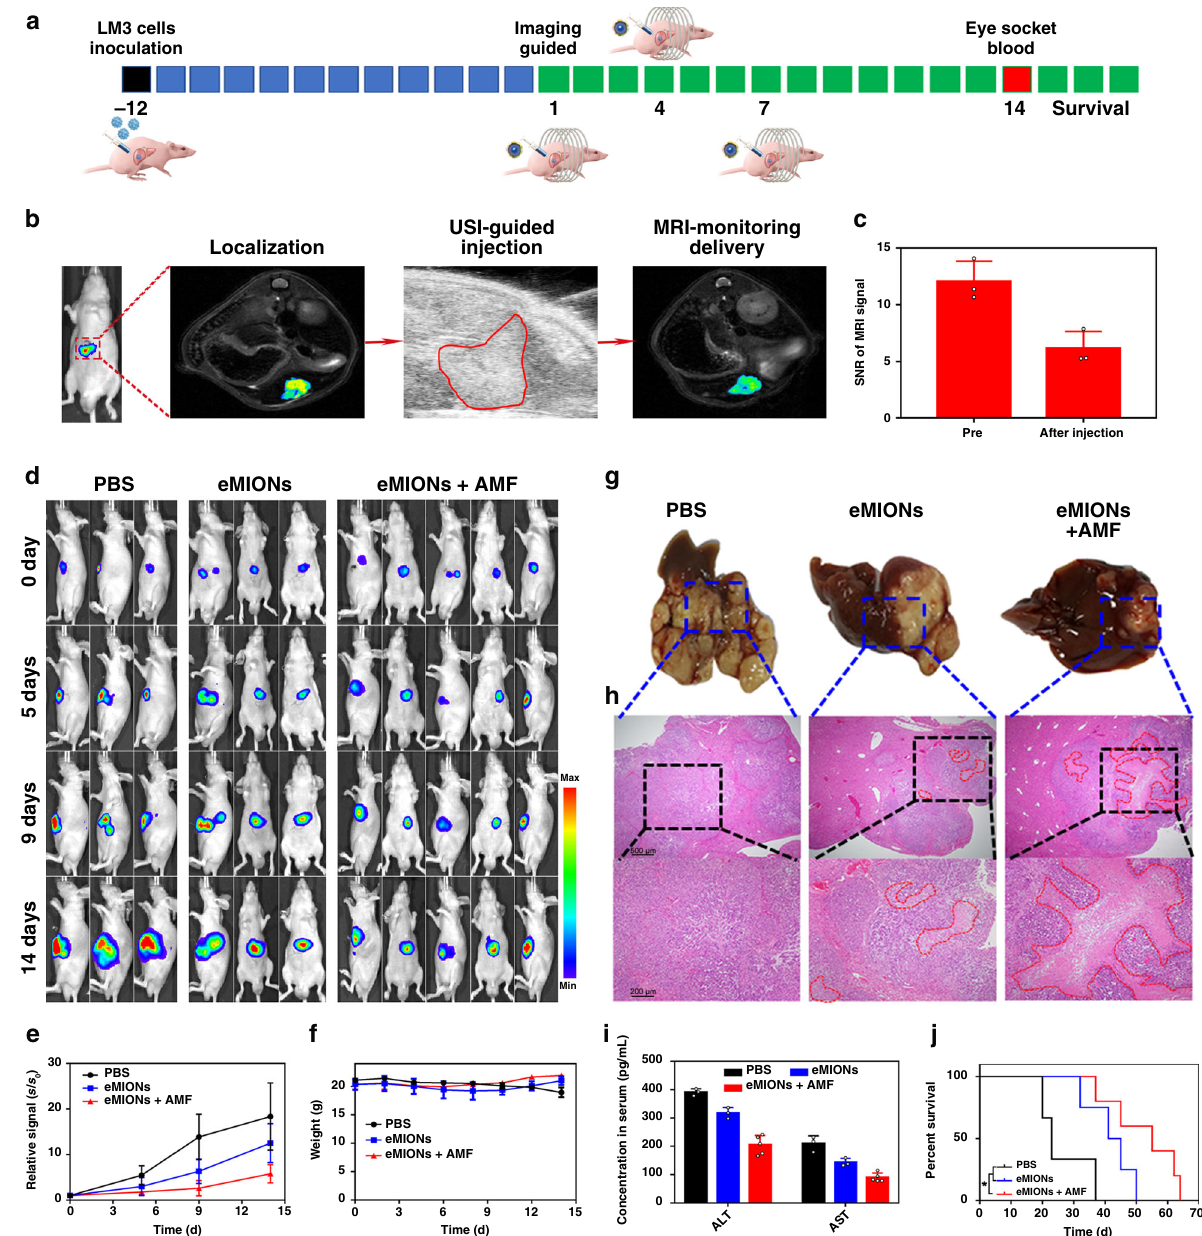
Fig. 6 Orthotopic hepatocellular carcinoma (HCC) model theranostics by encapsulin-produced magnetic iron oxide nanocomposites (eMIONs). a Schematic illustration of animal therapy by eMIONs. b Orthotopic HCC model veri fi ed and multimodality imaging-guided eMION delivery. c Semiquantitative analysis of magnetic resonance imaging (MRI) before/after eMIONs injection. Data are presented as mean ± SD ( n = 3 biologically independent mice). d Bioluminescence imaging of LM3 tumors in response to eMIONs treatment with/without alternative magnetic fi eld (AMF). e , f Growth curves for tumors ( e ) and body weight changes of mice ( f ) with different treatments. Data are presented as mean ± SD (Group PBS and eMIONs, n = 3 biologically independent mice, and group eMIONs + AMF, n = 5 biologically independent mice). g , h Representative orthotopic HCC ( g ) and H&E stain results at 2 weeks after therapy ( h ). Scale bar of the above pictures: 500 μ m; scale bar of neither pictures: 200 μ m. i Liver function was detected 2 weeks after therapy. j Survival curves of mice after therapy ( n = 5 biologically independent mice). Statistical signi fi cance was calculated with two-tailed Student ’ s t test ( P = 0.047), and * indicated that P <